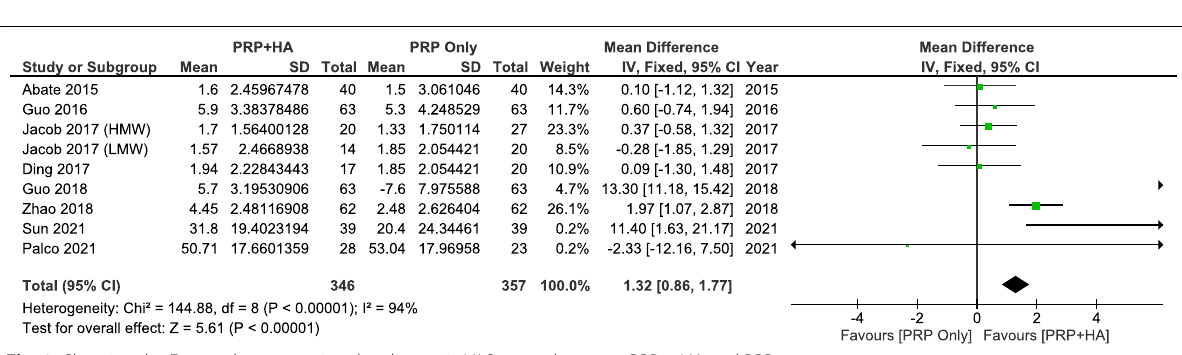
0.007 < 0.05) (Fig. 16). = 4.90 points, which −